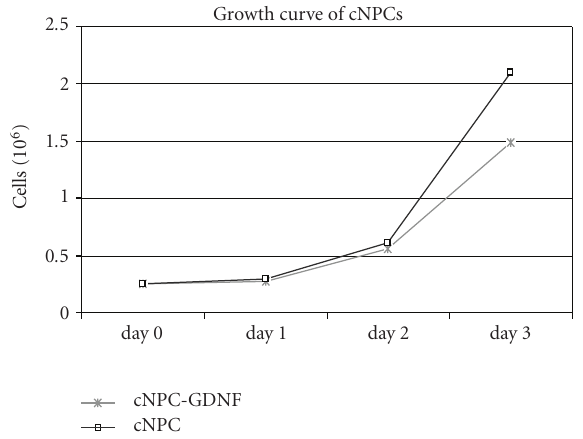
Figure 2: Growth properties of transduced versus nontransduced cNPCs. The growth of lenti-GDNF-GFP vector transduced cNPCs was compared to nontransduced cNPCs under proliferation con- ditions (UM). One flask of each type of cells was harvested and counted daily for 3 consecutive days. From this data it can be seen that the transduced cNPCs continued to proliferate despite overexpression of GDNF and that growth was similar to that of nontransduced cells out to day 2, after which the nontransduced cells exhibited relatively greater growth at the day 3 time point.